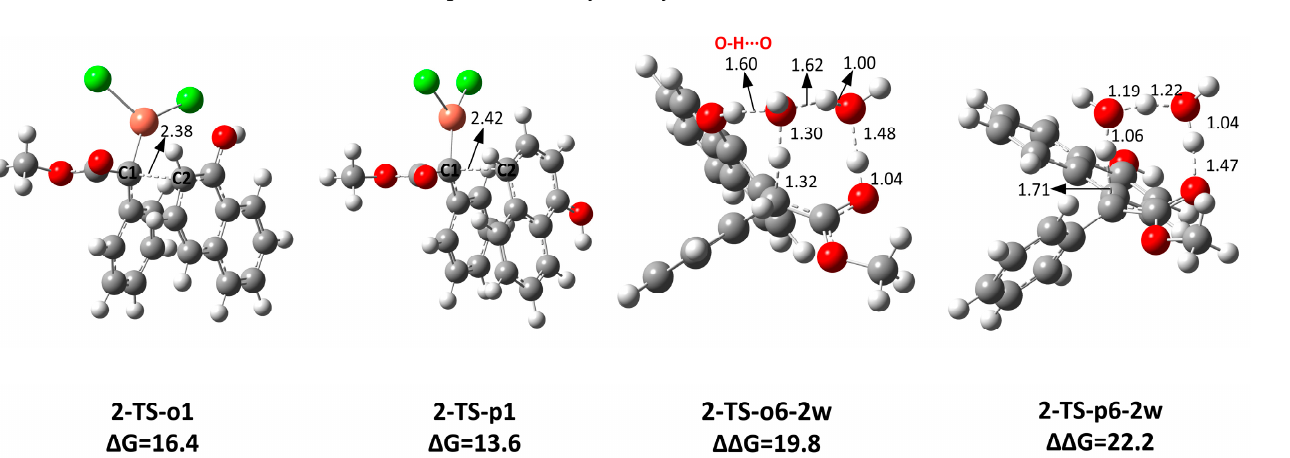
Figure 6. Optimized geometries of four transition states 2-TS-1o , 2-TS-1p , 2-TS-o6-2w , and 2-TS- 6p-2w corresponding to Figure 5. The distances are in the units of angstroms and the values of free energy barriers are in kcal mol − 1